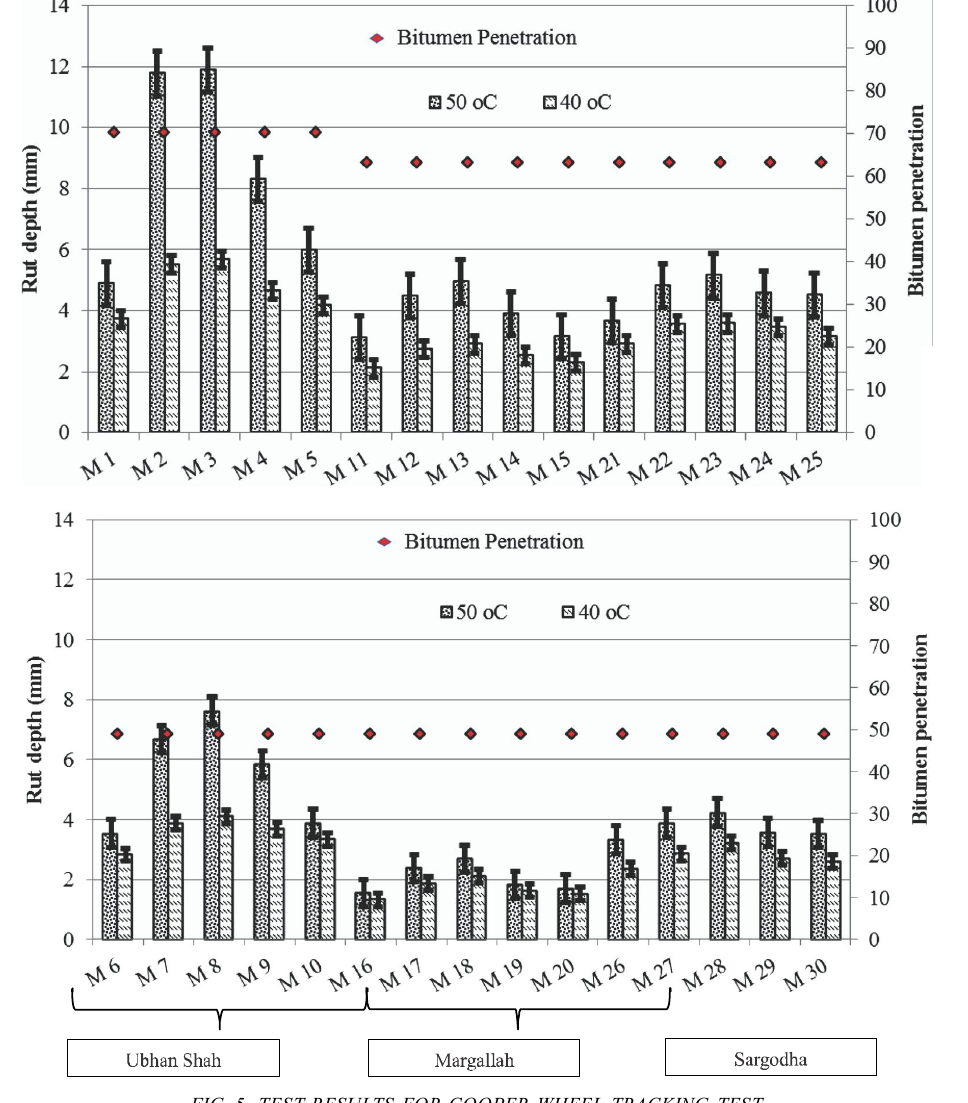
FIG. 5. TEST RESULTS FOR COOPER WHEEL TRACKING